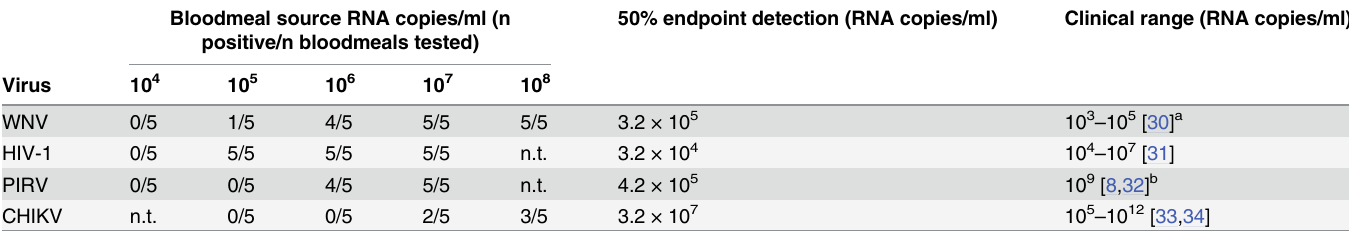
Table 1. Mosquito bloodmeal limits of detection and comparisons to clinical ranges. Bloodmeal source RNA copies/ml (n positive/n bloodmeals